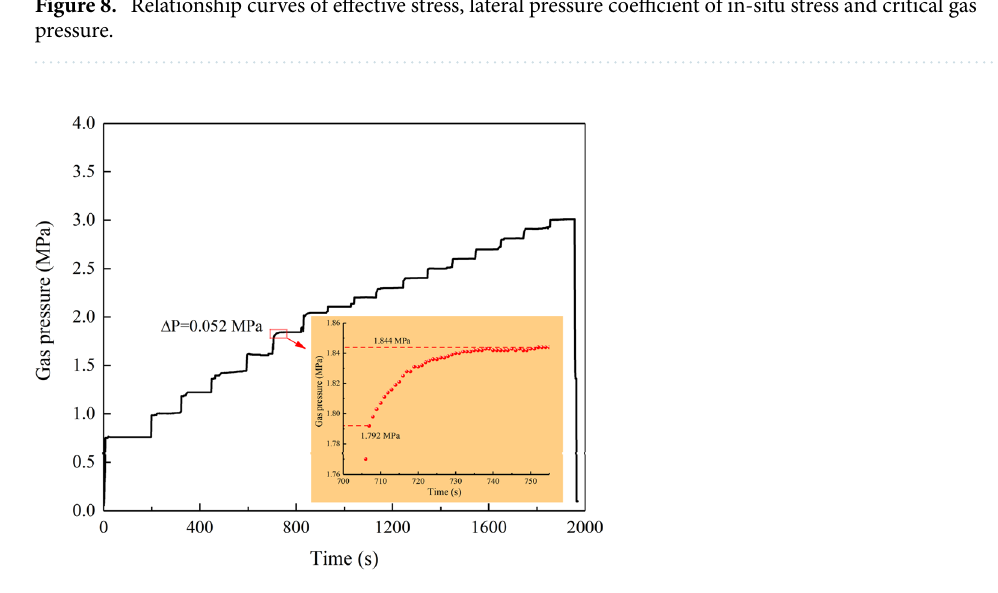
Figure 9. Evolution of gas pressure at 600